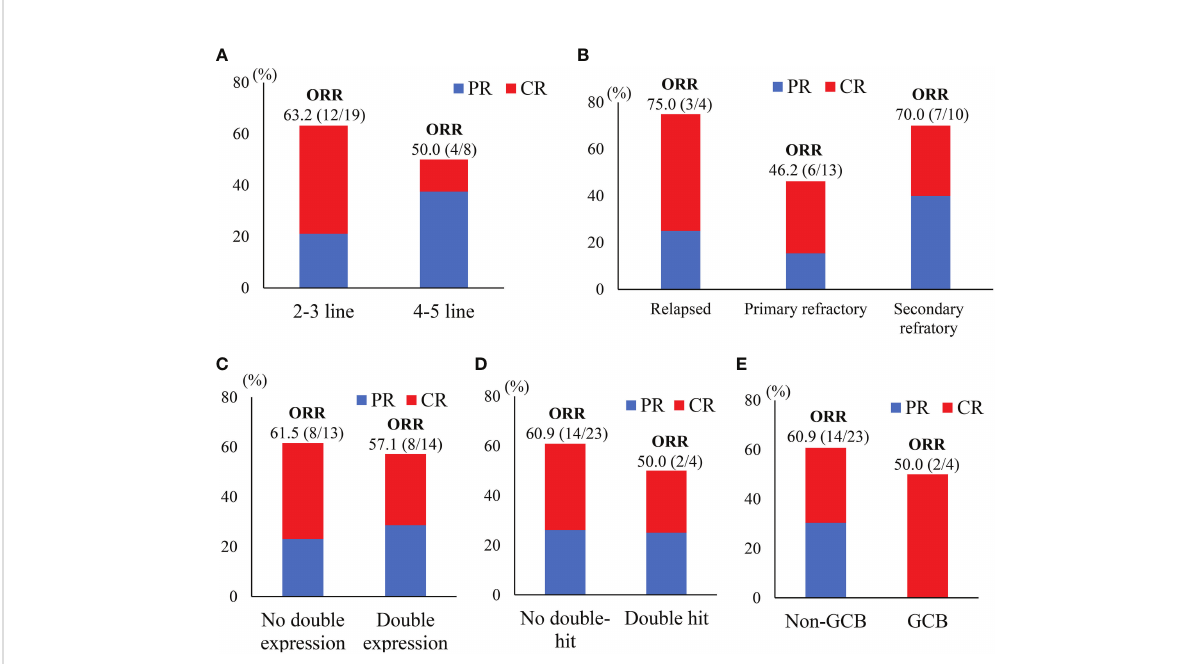
FIGURE 2 Subgroups responses to treatment. (A) Treatment lines; (B) disease status; (C) immunohistochemical analysis; (D) with or without double-hit; (E) cell of origin based on Hans ’ s